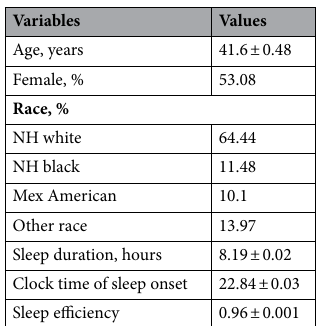
Table 1. General characteristics of the participants ( n = 11,279). For continuous traits, data are present as mean ± SE. NH Non-Hispanic, Mex Mexican.